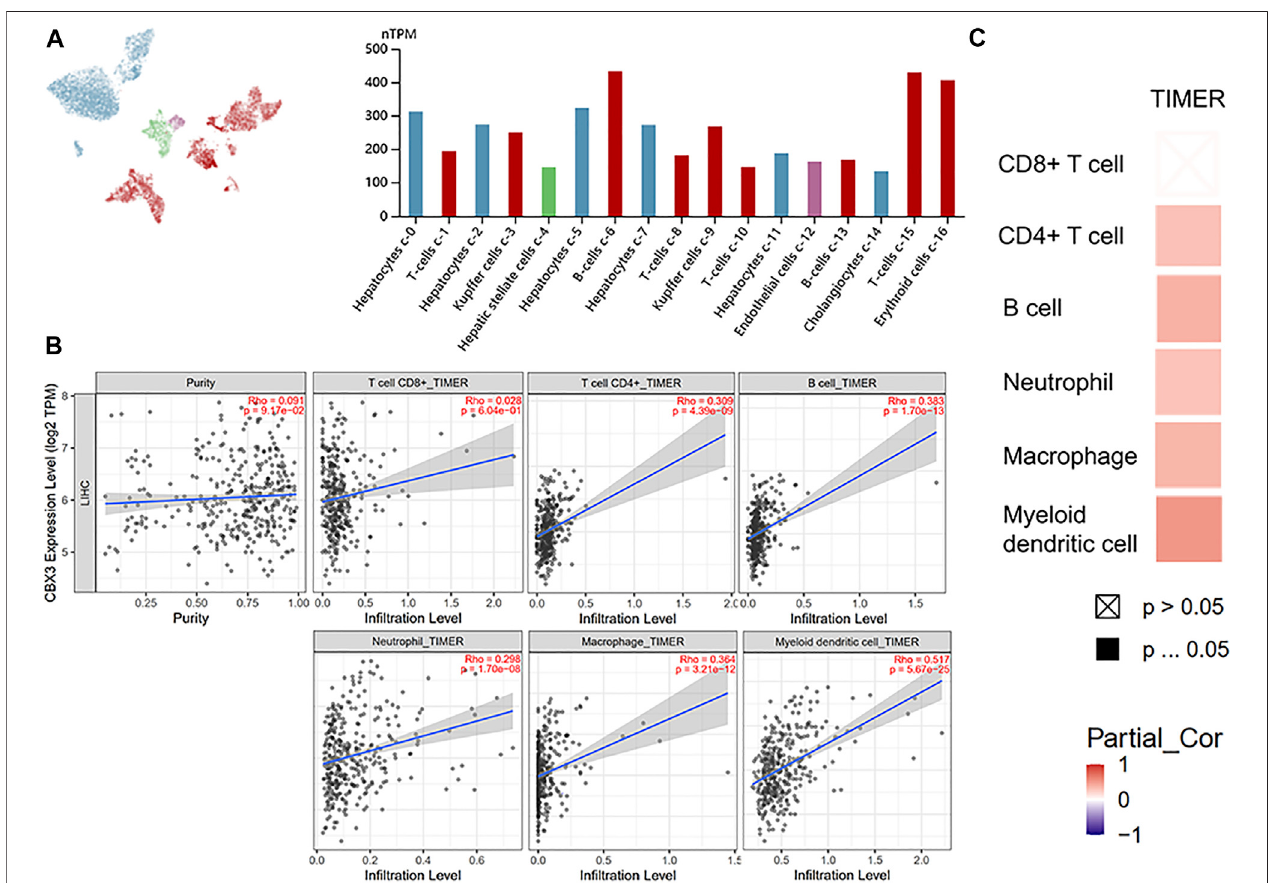
FIGURE5|(A) CBX3andliversinglecellsequencingresults(HPA) (B) TherelationshipbetweenthenumberofimmunecellsandCBX3expression. (C) Aheatmap depicting the number of immune cells and CBX3